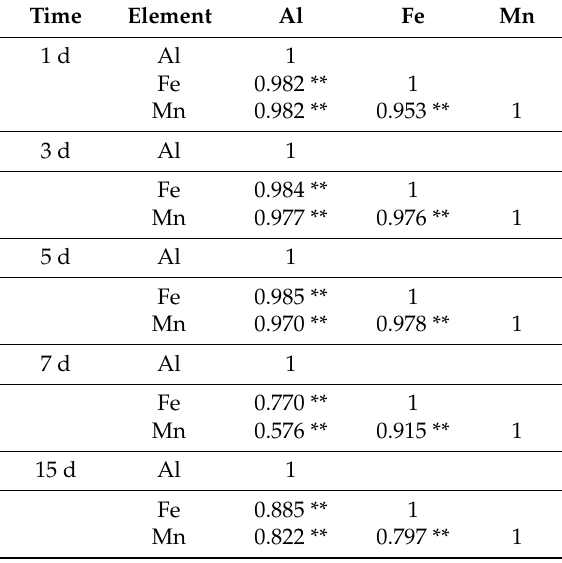
Table 5. Correlation coefficient among Fe, Mn, and Al in the solution samples ( n = 7). Time Element Al Fe Mn